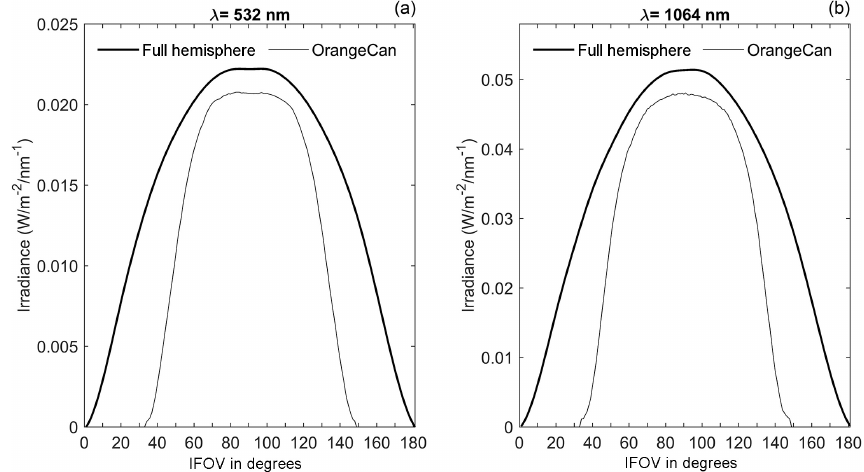
Figure 5. Laboratory characterization of the zenith-viewing remote cosine receptor optic using a NIST-traceable point source. Green (a) and NIR (b) wavelengths at which SIMPL operates were used to summarize the OrangeCan’s impact on the remote cosine receptor optic IFOV and measured